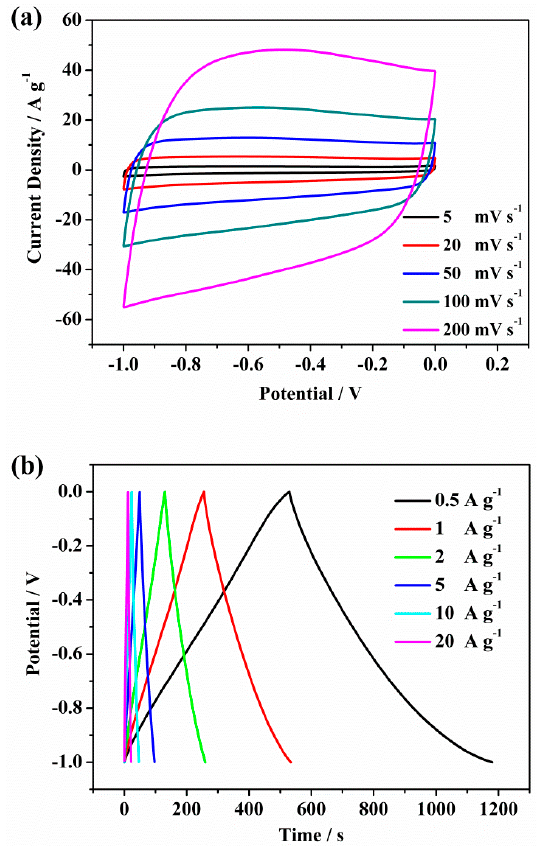
Figure 3. ( a ) CV curves of KAC-800 at different scan rates; ( b ) galvanostatic charge–discharge cycling (GCD) curves of KAC-800 at various current densities.